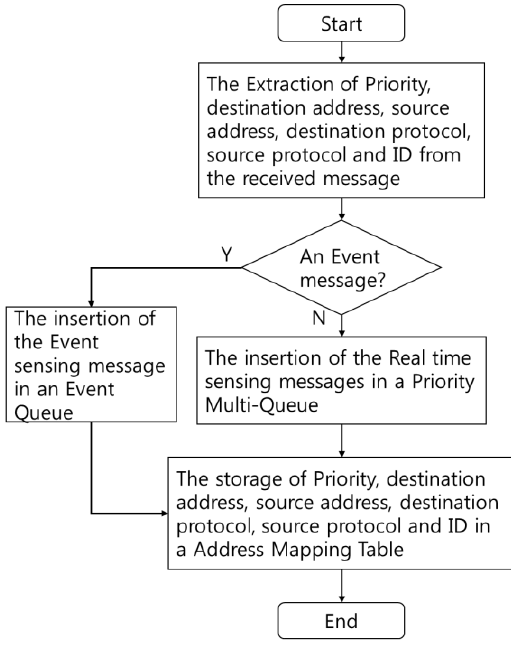
Figure 4. The flowchart to process the received message.